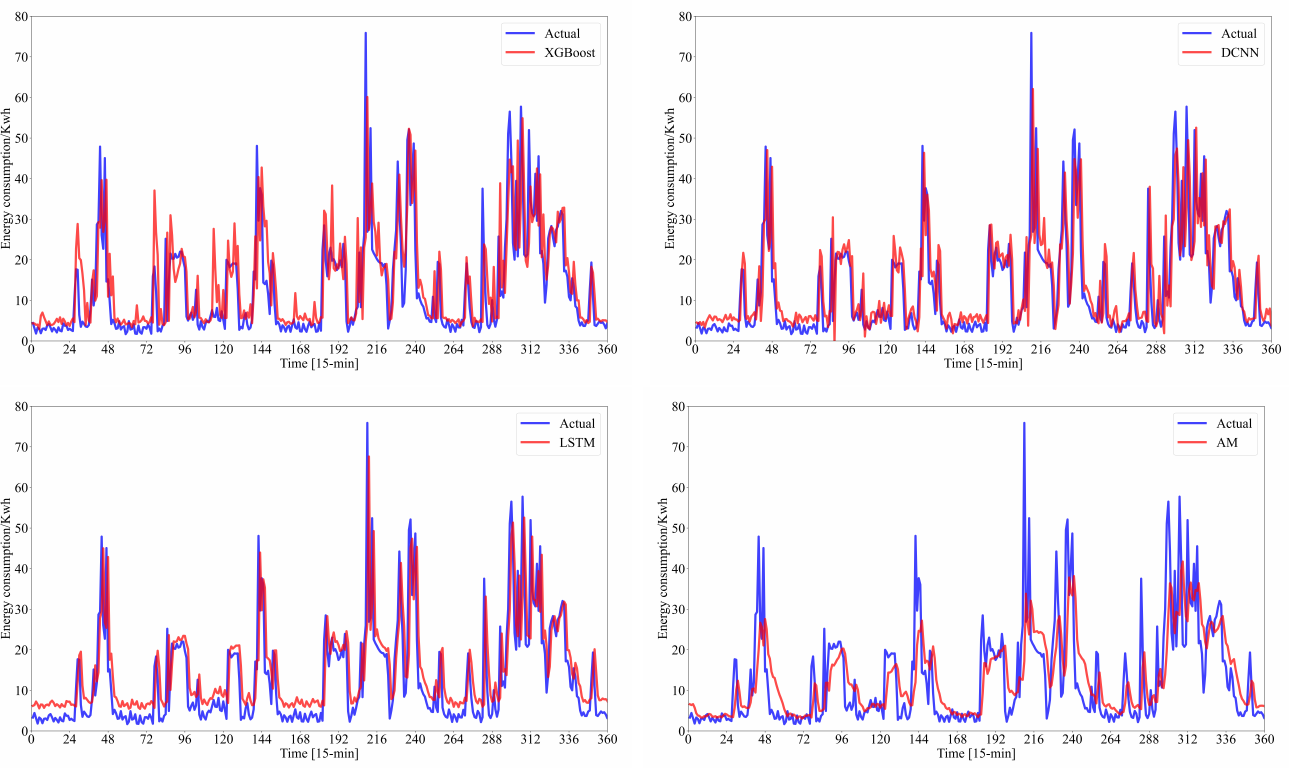
Figure 11. Prediction results of some sole models on the IHEPC dataset at a 15-min resolution. From Figure 12, one can have that: (1) Different hybrid models have different predic- tion results. (2) The LSTM-AE is similar to the LSTM, which further narrows the numerical gap. (3) Although the CNN-LSTM is sensitive to data with large fluctuations in value